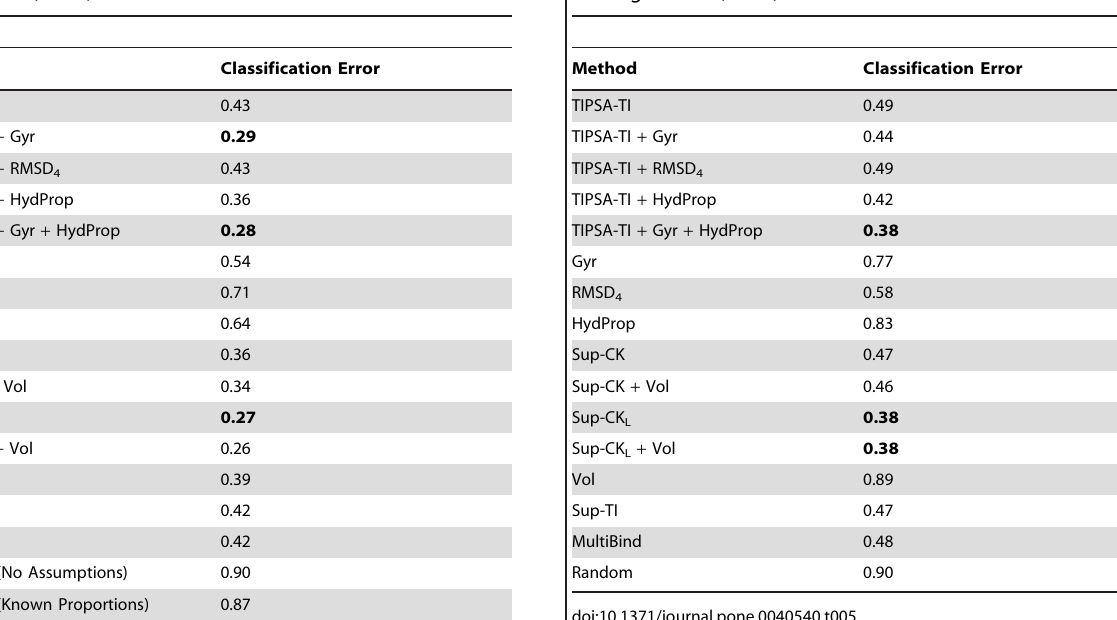
Table 4. Results of k -nearest neighbor classification for the Kahraman (5.3 A˚) data set.